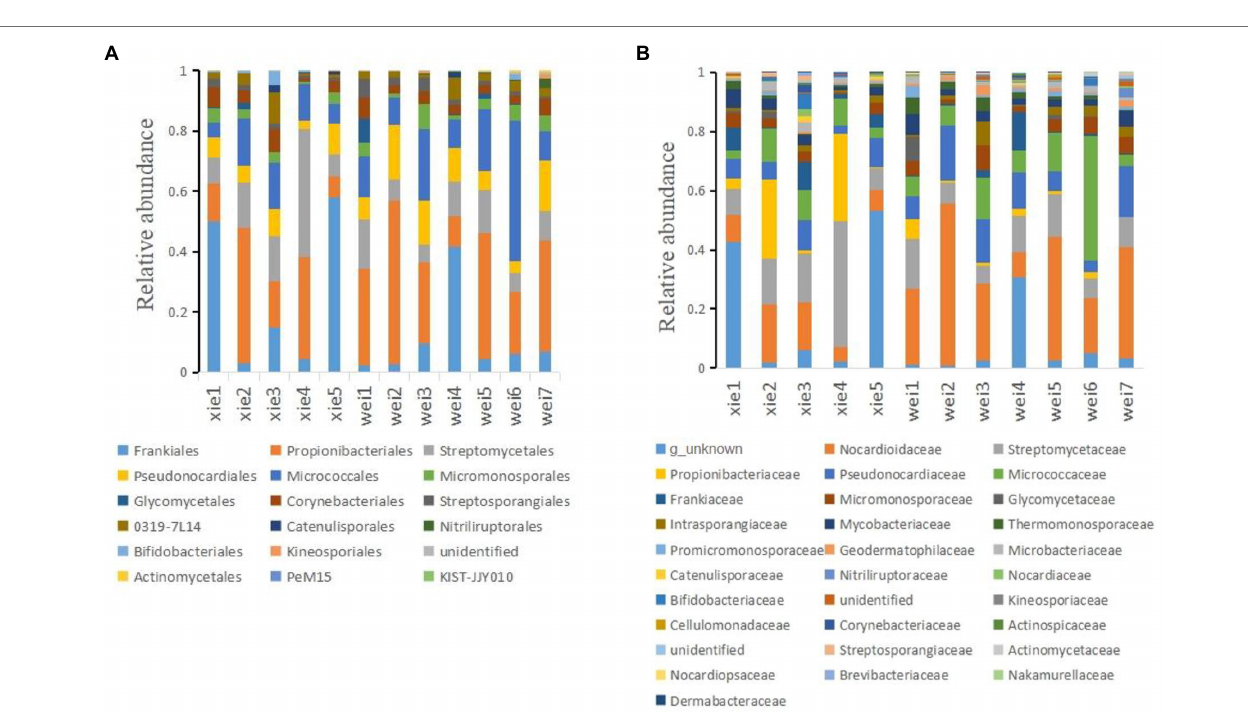
FIGURE 7 | The relative abundances of different Actinobacteria at different taxon levels on the Weizhou and Xieyang Islands according to an HTS-based analysis. (A) Order taxon level; (B) family taxon level. “xie1–xie5” and “wei1–wei7” indicate soil samples from Xieyang and the Weizhou Islands,